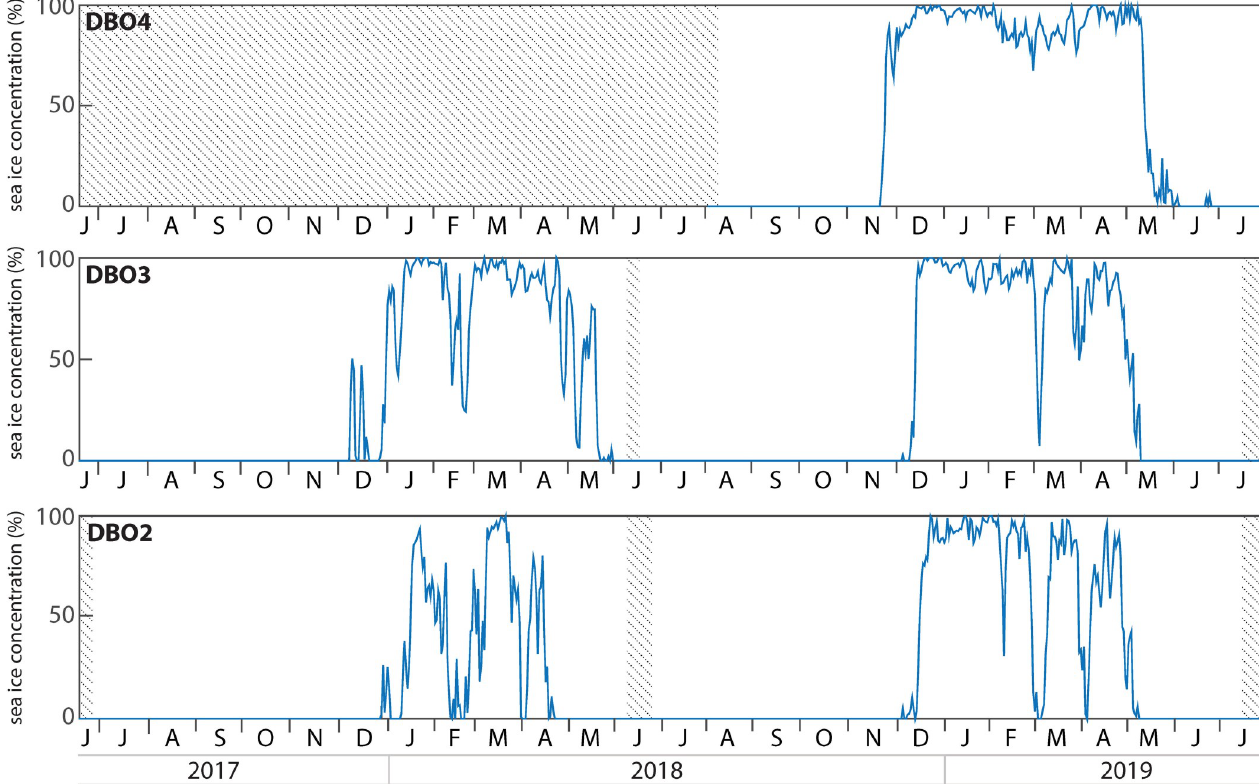
PLOS ONE | https://doi.org/10.1371/journal.pone.0255837 August 16,